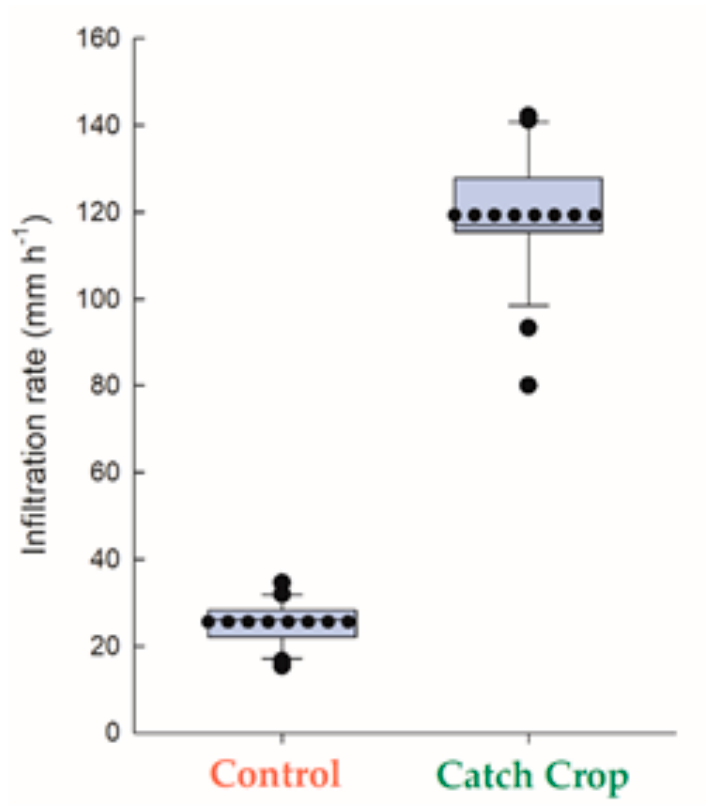
Figure 5. Variability of infiltration rates in the 25 different plots with catch crops and without them. In the box plot graph: continuous line: median values; dotted line: mean values; circles: outliers; 5th and 95th percentiles are also represented per box plot.